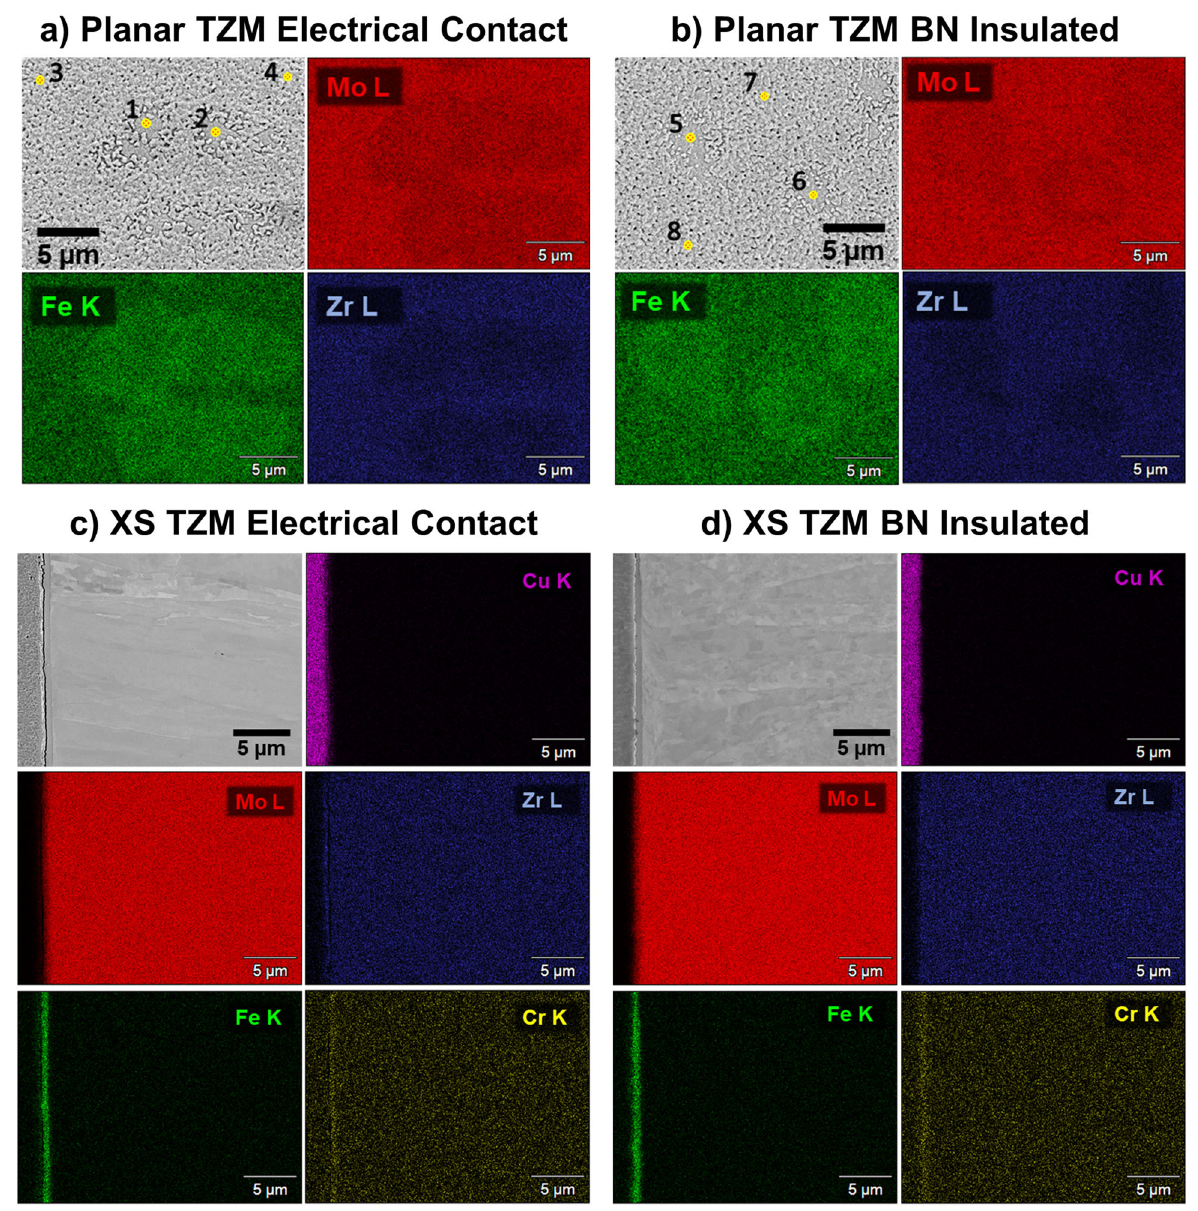
Fig. 4 SEM/EDS analysis of TZM. a , b Planar analysis performed on the salt facing surface of the TZM sample held in electrical contact with the 316L-SST capsule and the sample BN insulated from the 316L-SST, respectively. c , d Cross-sectional (XS) analysis of the sample held in electrical contact with the 316L-SST capsule and the sample BN insulated from the 316L-SST capsule, respectively.